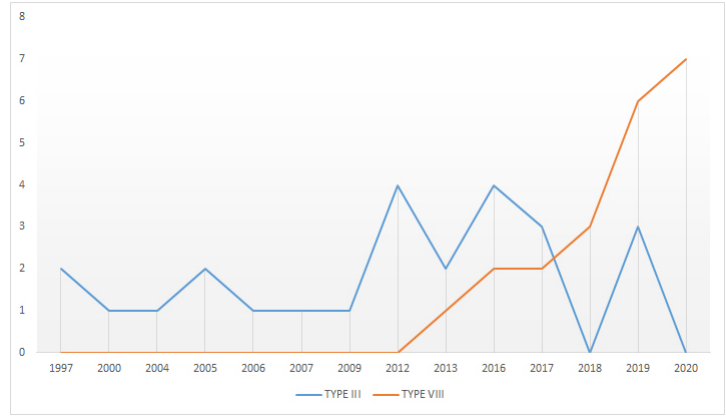
Figure 12. Comparative study of KE